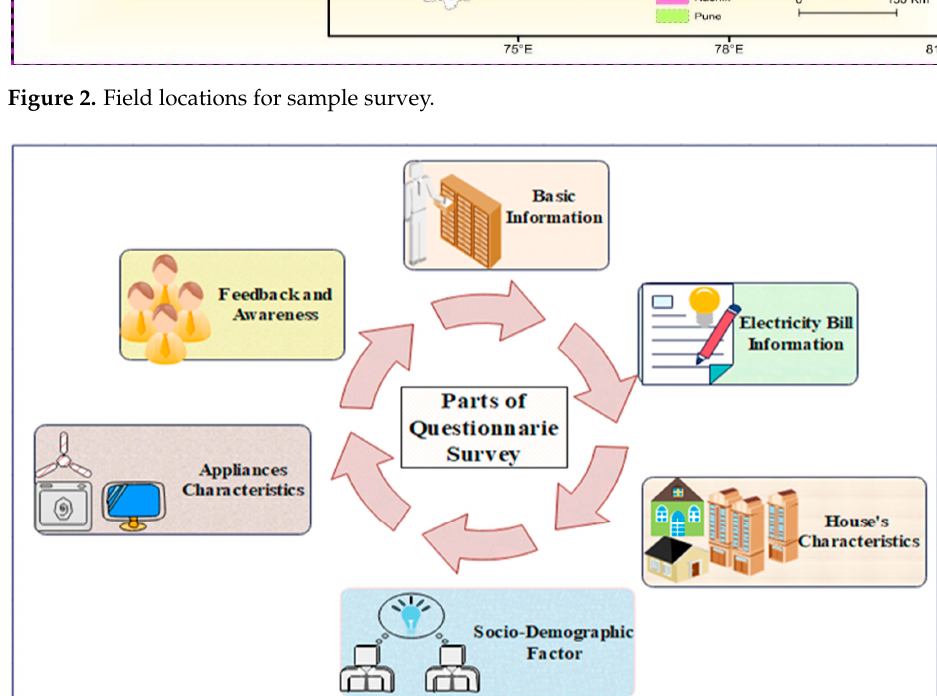
Figure 3. Parts of a questionnaire.